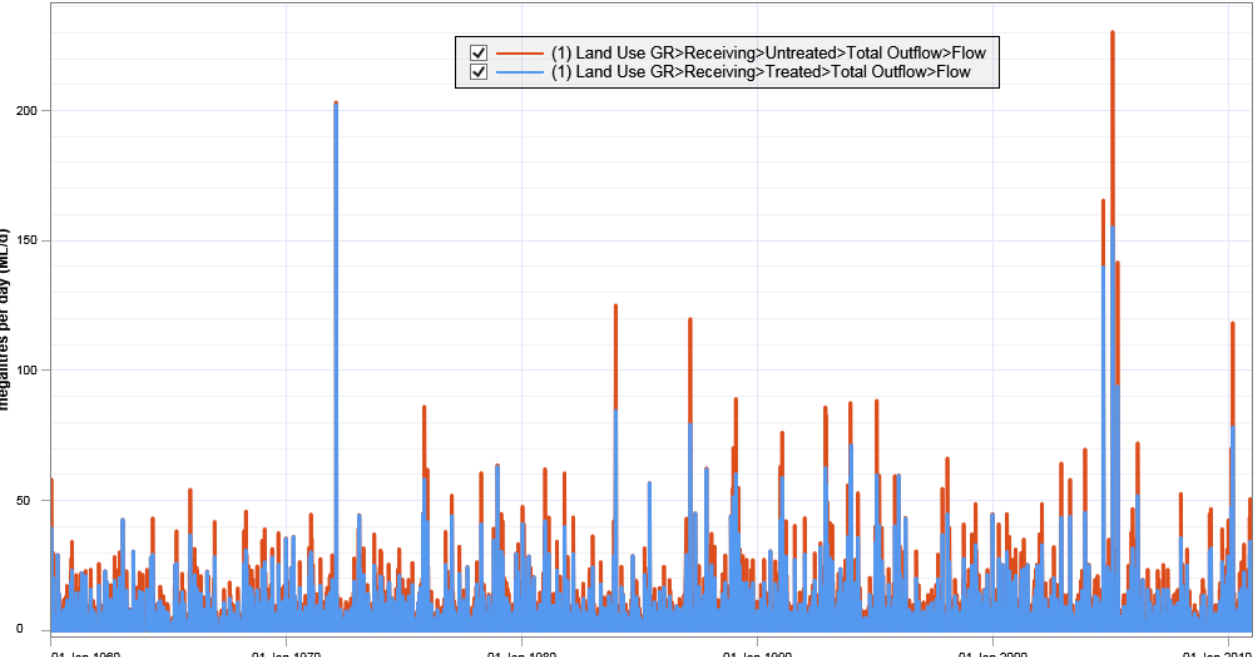
Figure 10. Comparison of outflow volume between treated and untreated scenarios using the land use node.